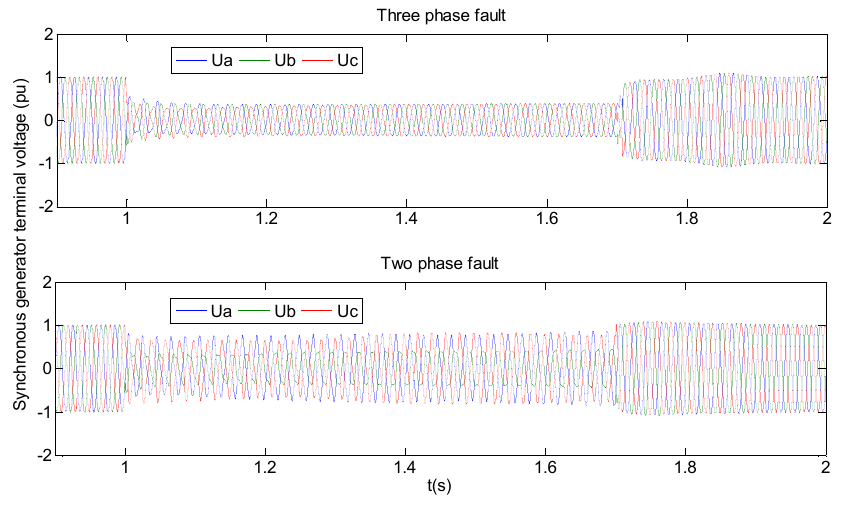
Figure 6. Synchronous generator terminal voltage.